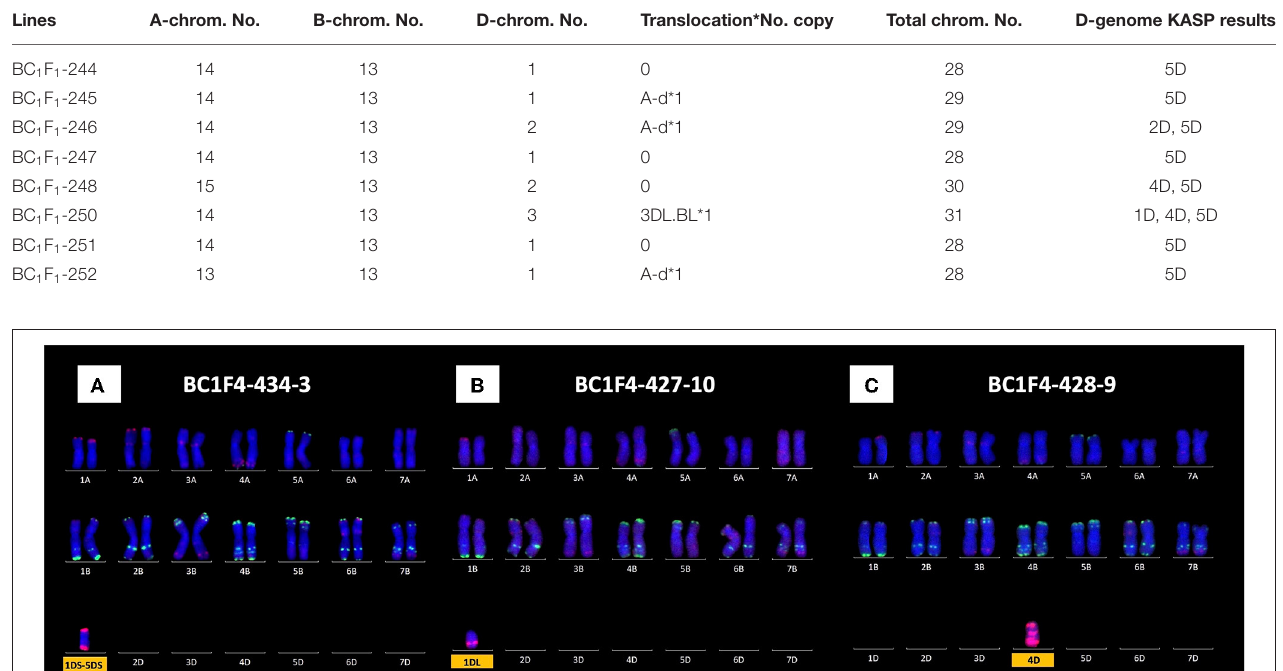
TABLE 1 | Genomic composition of the BC 1 F 1 lines.